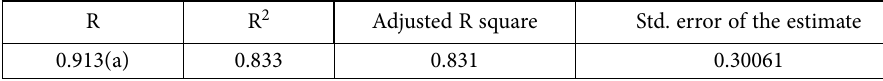
Table 4. Summary of the model for all countries R R 2 Adjusted R square Std. error of the estimate